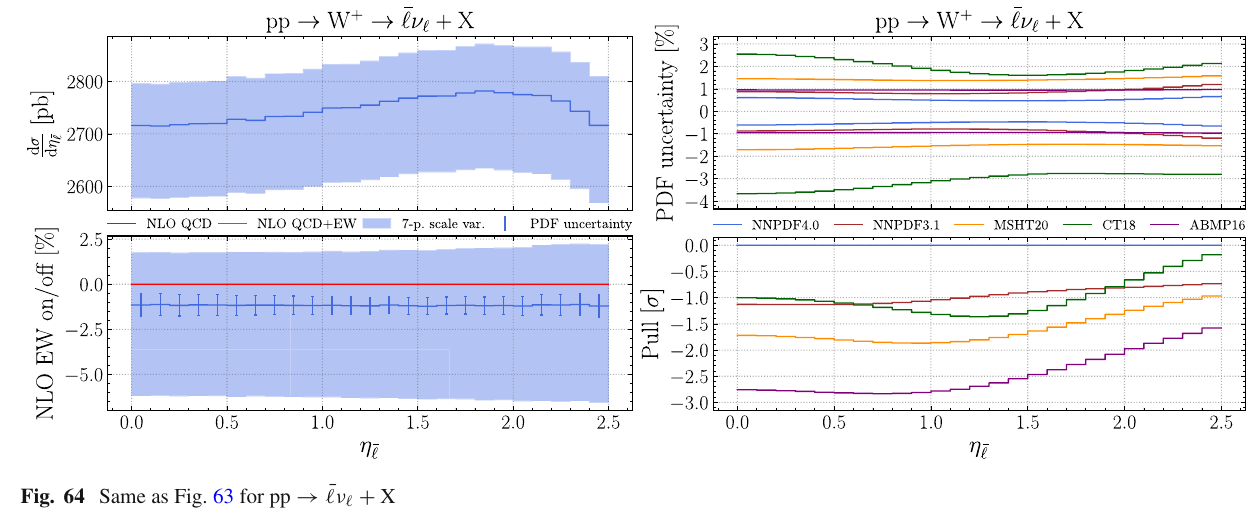
Fig. 64 Same as Fig. 63 for pp → ¯ (cid:5)ν (cid:5) +